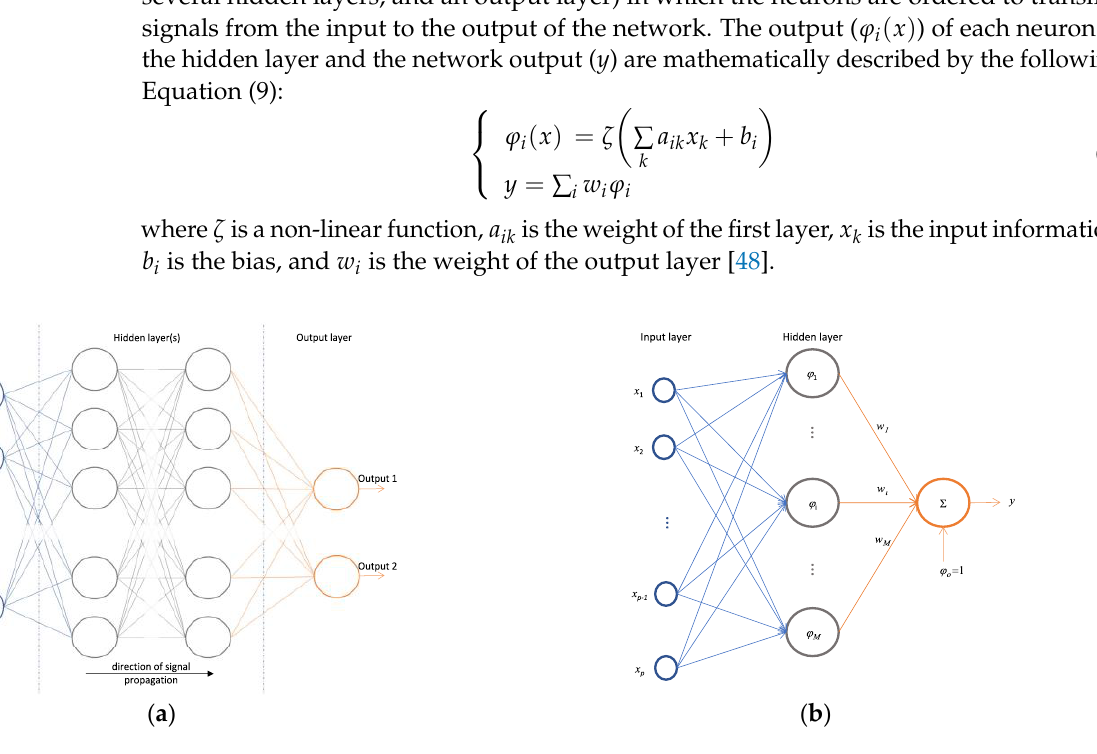
Figure 8. General architectures of ( a ) multilayer perceptron and ( b ) radial basis function neural net- works.